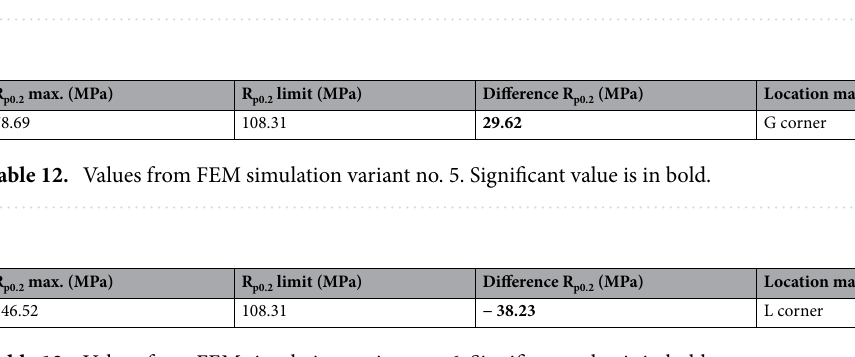
Table 11. Values from FEM simulation variant no. 4. Significant value is in bold.